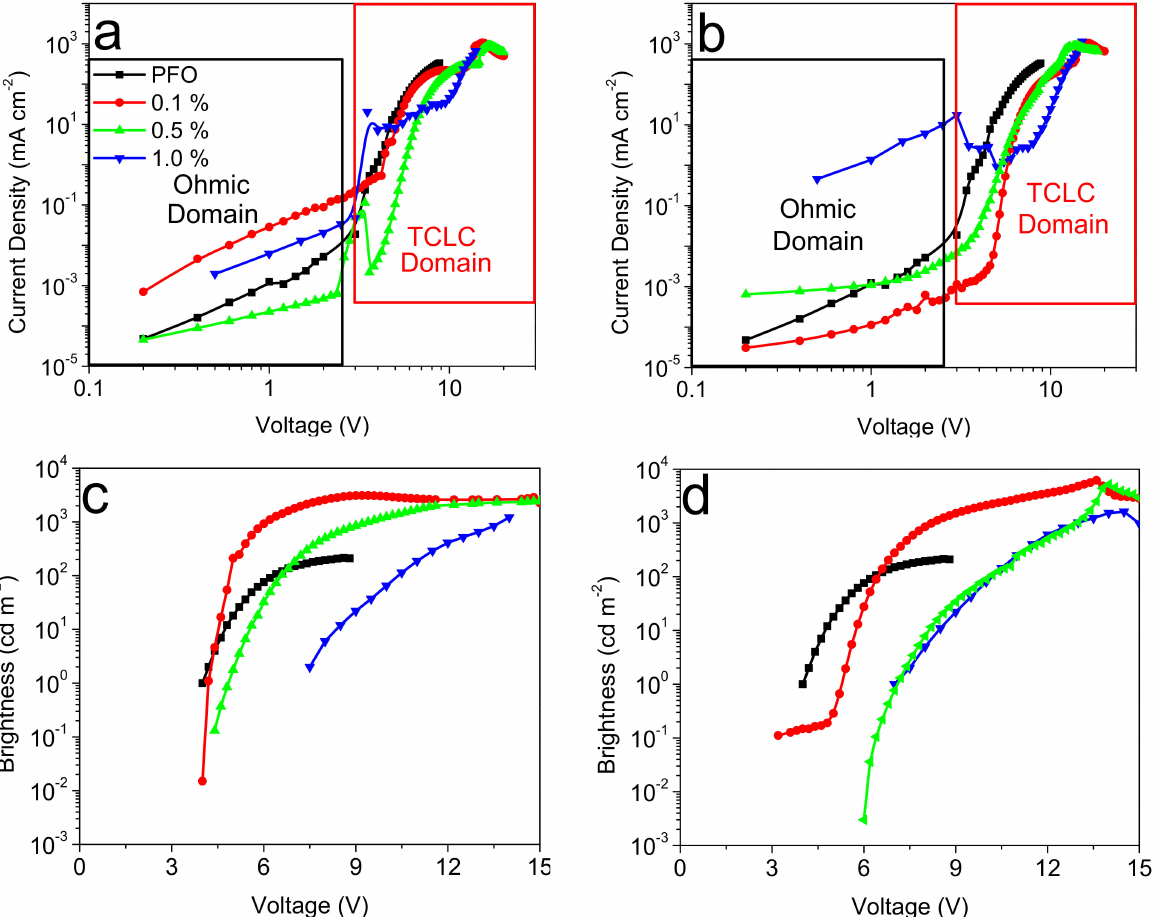
Figure 6. Optical-electronic properties of the diodes ITO|PEDOT:PSS/PVK/PFO:[Pt(salicylidene)s]/ Ca|Al: current density and brightness vs. the voltage data of [Pt(salophen)] ( a , c ) and [Pt(sal-3,4-ben)] ( b , d )-based